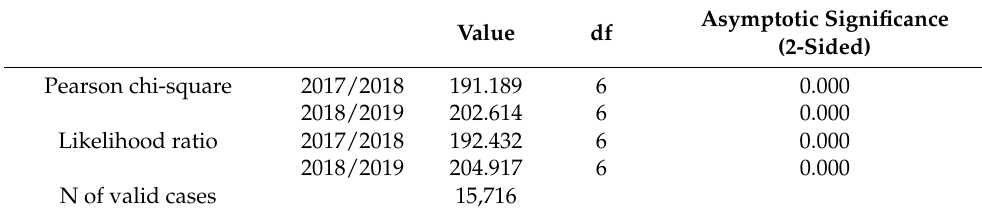
Table 2. Chi-square test (firm size vs. discretionary